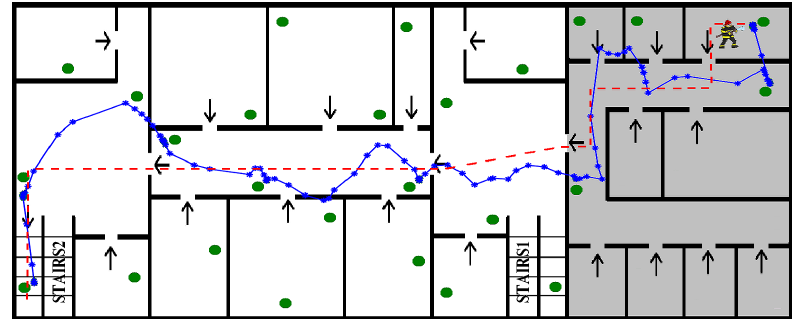
Figure 14. Maps of the second ( a) and first ( b ) floors of the building with fire conditions and guiding information at time t . The straight-line representation of the escape path (dashed 2 line) and the actual trajectory followed by FIREMAN2 (solid line) are also